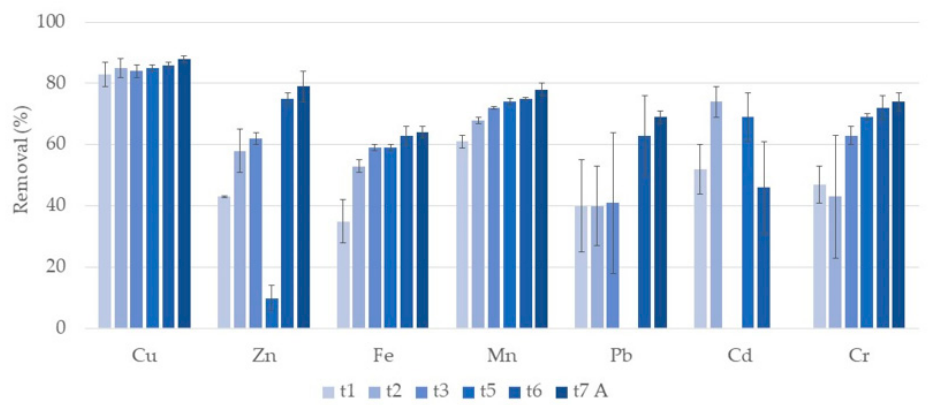
Figure 1. Removal percentage and respective standard deviation ( n = 3) for each metal, in constructed wetlands (CWs) with expanded clay (A) and P. australis during the first week of treatment. Samples taken after one day (t1), two days (t2), three days (t3), five days (t5), six days (t6) and seven days (t7) of treatment. At t5 there was no removal for Pb. For Cd no removal was observed at t3.